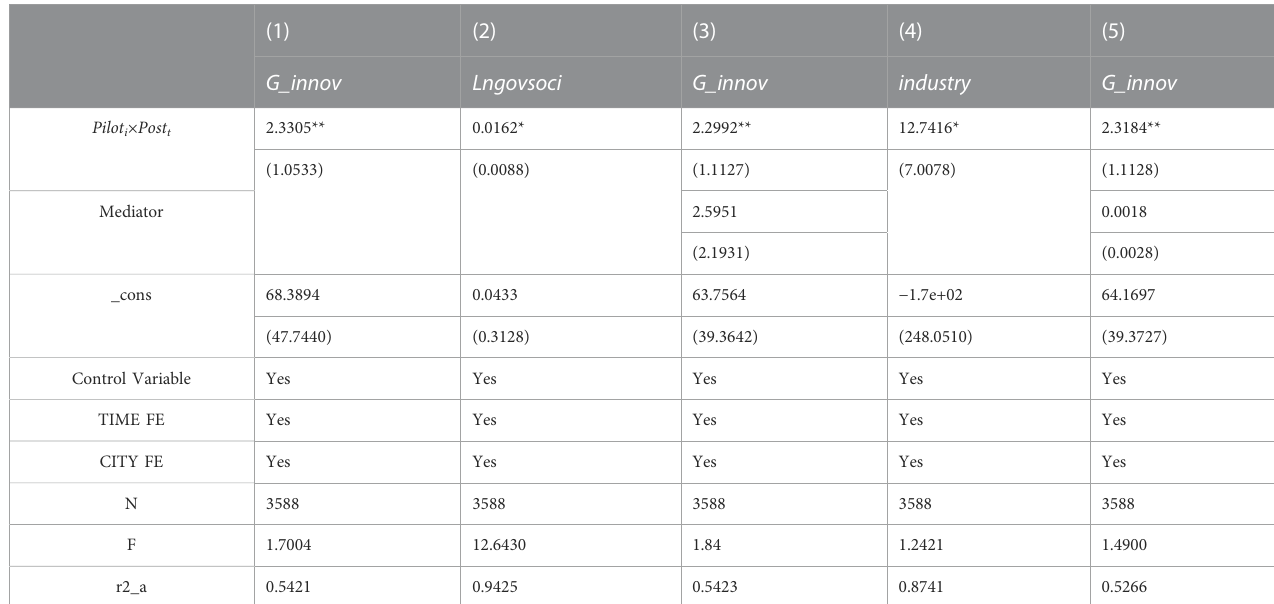
TABLE 5 Mechanistic